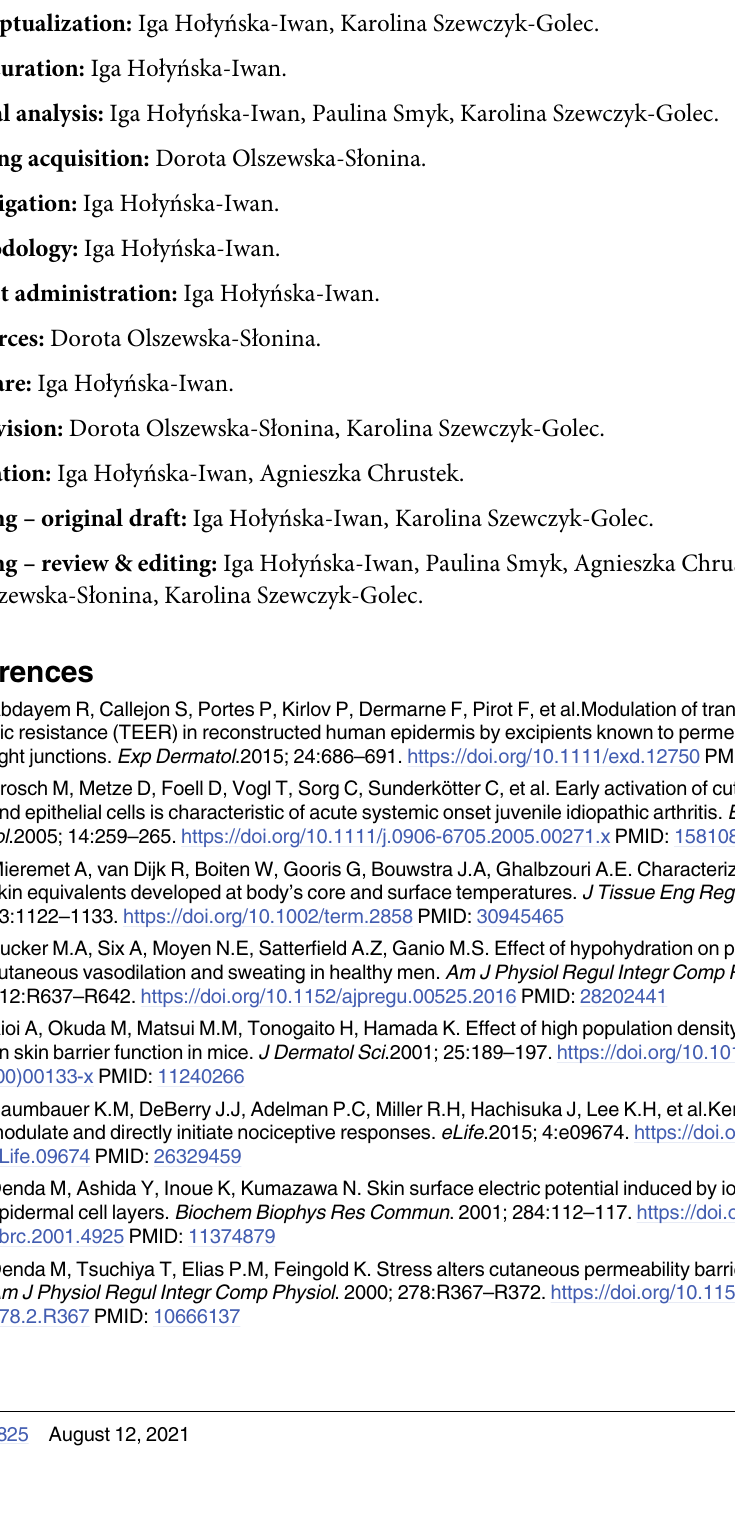
S6 Table. The Wilcoxon test p values for mechanical-chemical stimulation by the